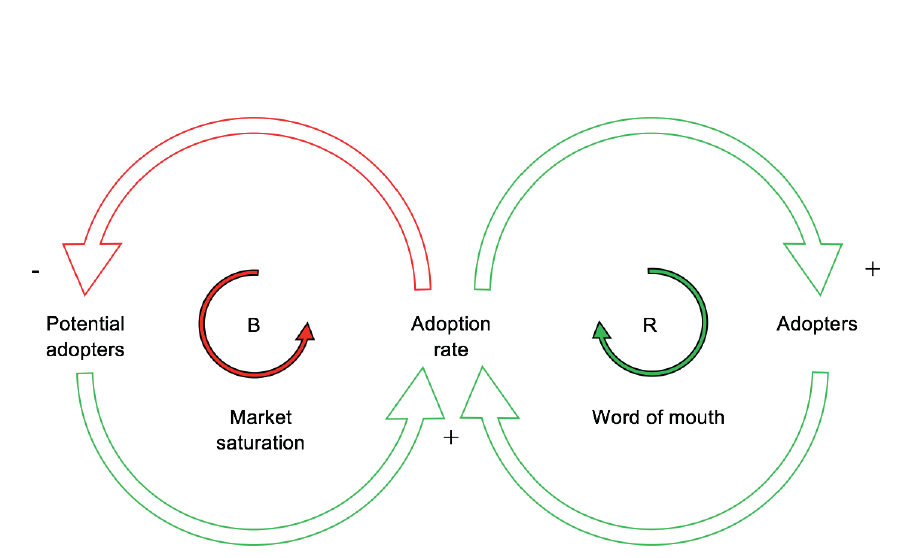
Fig. 1. Cause loop diagram for the new product acceptance module (Sterman,